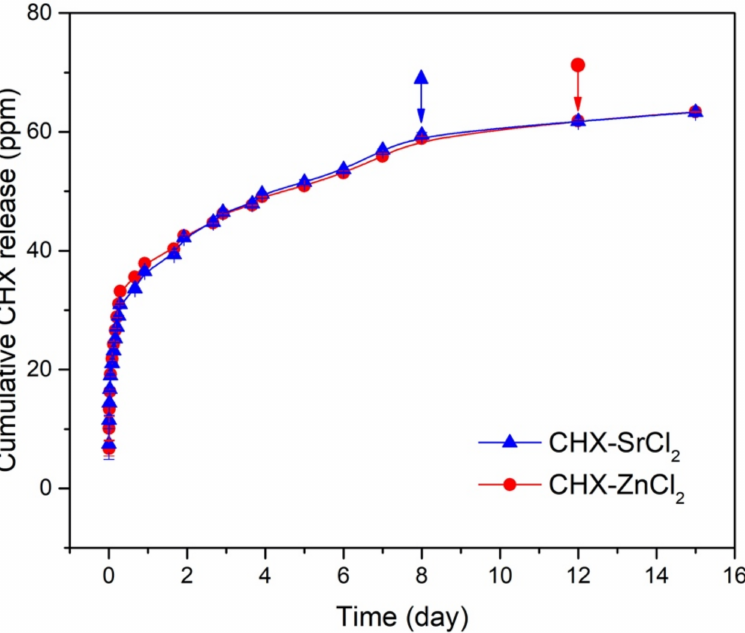
Figure 7. Cumulative CHX release curves for CHX-SrCl 2 and CHX-ZnCl 2 particles in PBS. Arrows with red round or blue triangle represent the last time point of the release CHX concentration higher than